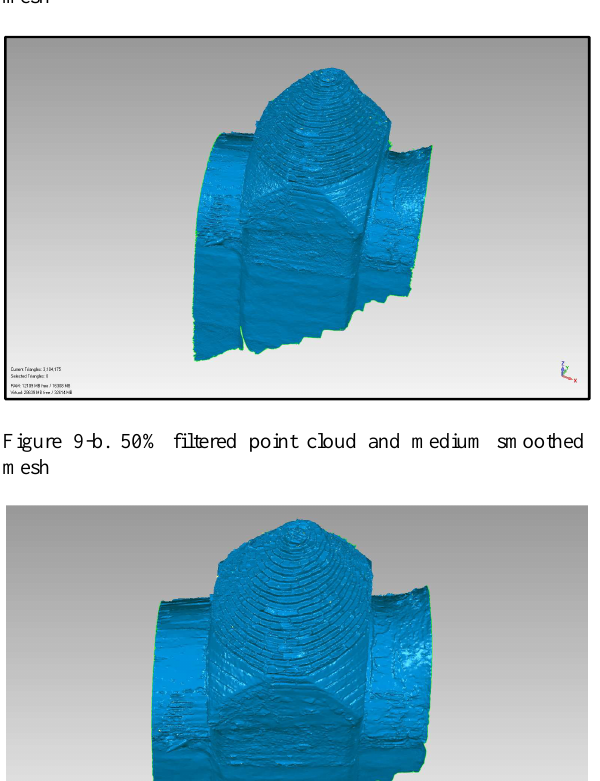
Figure 8-a. Medium mesh models from 25% filtered point cloud